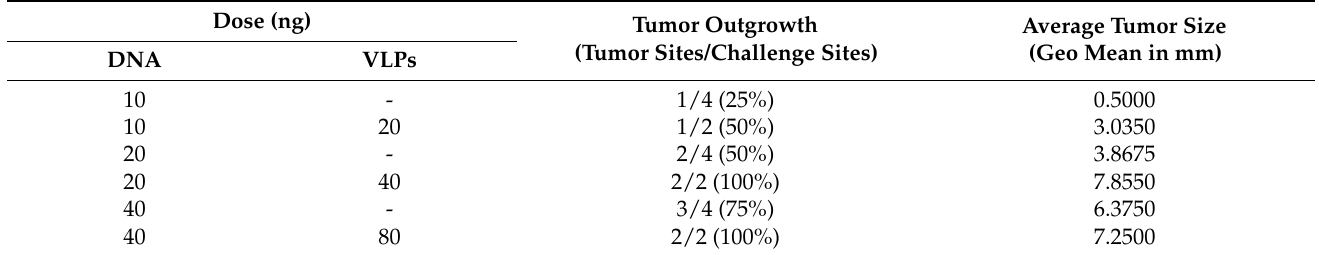
Table 2. CRPVL1/L2 VLPs increase the infectivity of DNA infection in